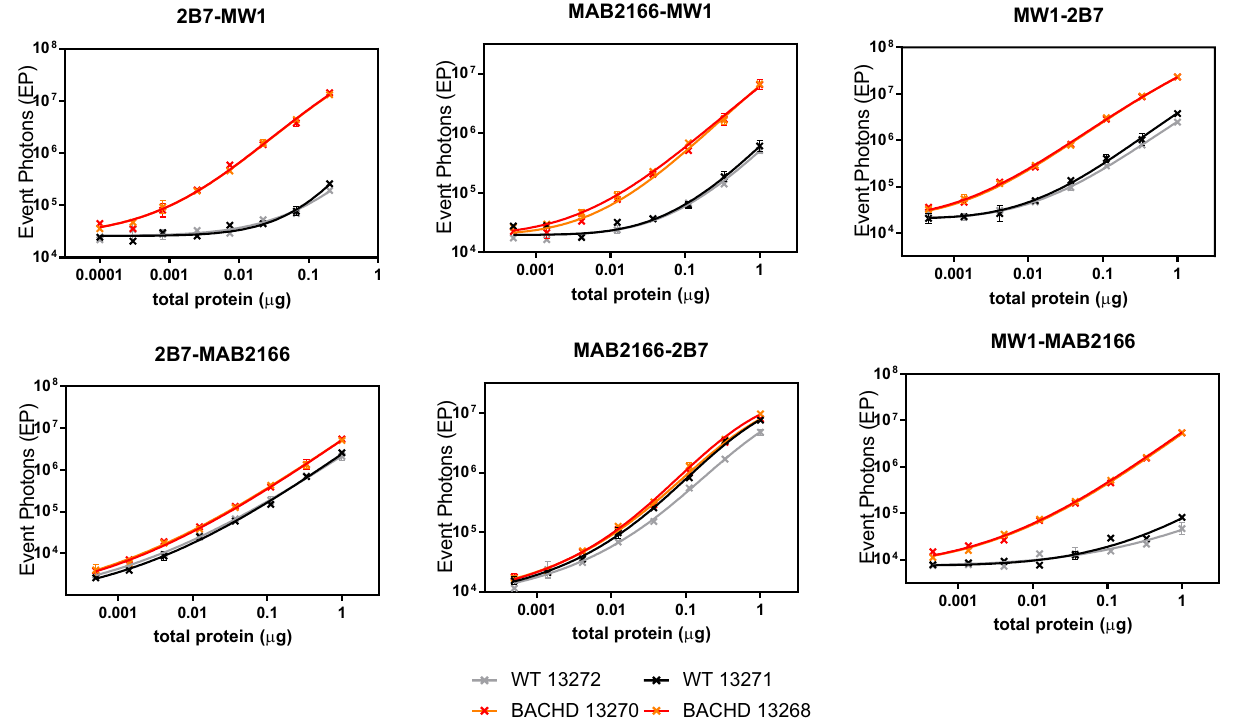
Figure 3. mHTT specificity of the detection in wild type and BACHD rat brain homogenates. Two wild type rats (13272 and 13271 grey and black respectively) and two BACHD rats (13270 and 13266 red and orange respectively) brain homogenates were diluted starting from 1.3 µg/ml total protein for the 2B7-MW1 assay and from 6.7 µg/ml total protein for all other antibody pairs. Each dilution curve was assayed via SMC using the antibody pair reported on the title of each chart. Each experimental point is reported as the average and standard deviations of a triplicate. Results for assays containing the HDB4E10 and 4C9 antibodies are reported in Fig.